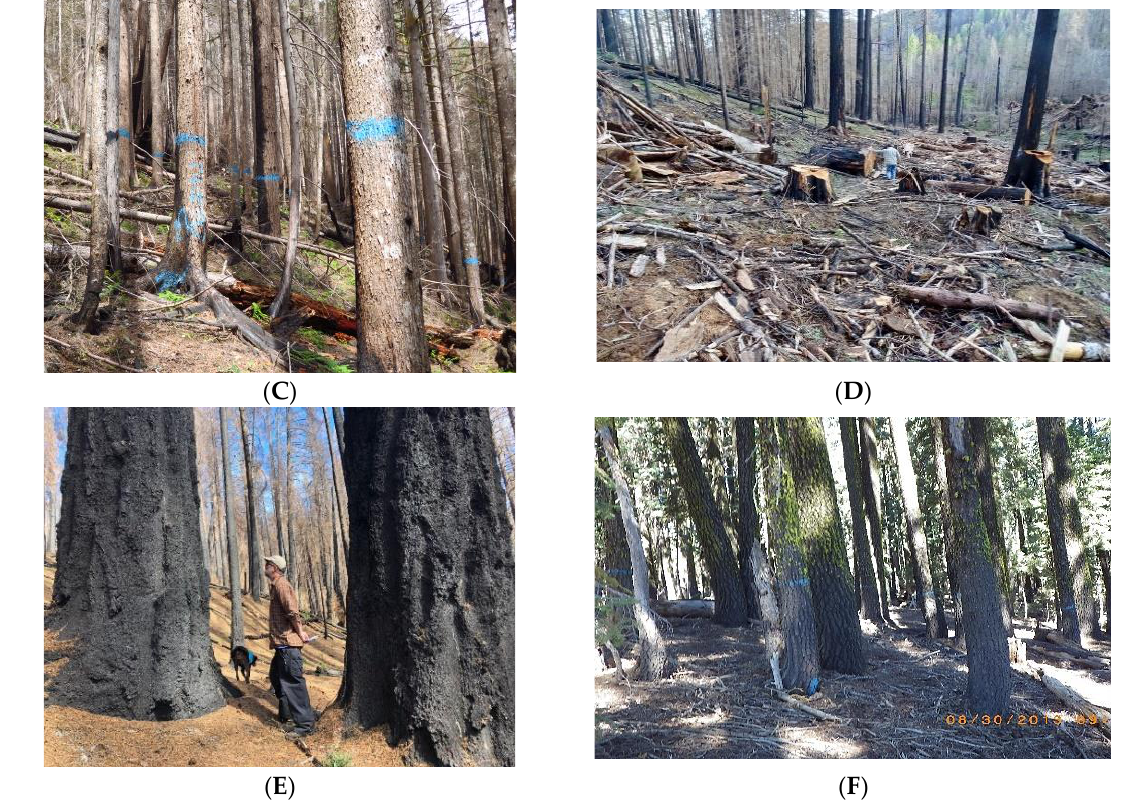
Figure 5. ( A ) Bureau of Land Management’s Picket West timber sale in NSO Critical Habitat in Oregon where fuel treatments will reduce overstory canopy closure to 40% (photograph Courtesy of Luke Ruediger). ( B ) Trees marked for logging in the Pilgrim project on California’s Shasta-Trinity National Forest in NSO occupied territories (photograph Courtesy of Doug Bevington). ( C ) Downey Creek timber sale in the Darrington Ranger District of the Mt. Baker-Snoqualmie National Forest in California showing large trees to be removed within a Late Successional Reserve (LSR) where fire occurred (photograph Courtesy of Kathy Johnson). ( D ) Post-fire logging within NSO core areas on the Bureau of Land Management’s Roseburg District in Oregon (photograph Courtesy of Francis Eatherington). ( E ) Seiad-Horse post-fire timber sale within an LSR on the Klamath National Forest in California (photograph Courtesy of George Sexton). ( F ) Trees marked for logging in an occupied NSO activity center in the Smokey project on the Mendocino National Forest in California (photograph Courtesy of Monica Bond). All photographs are with permission from their copyright